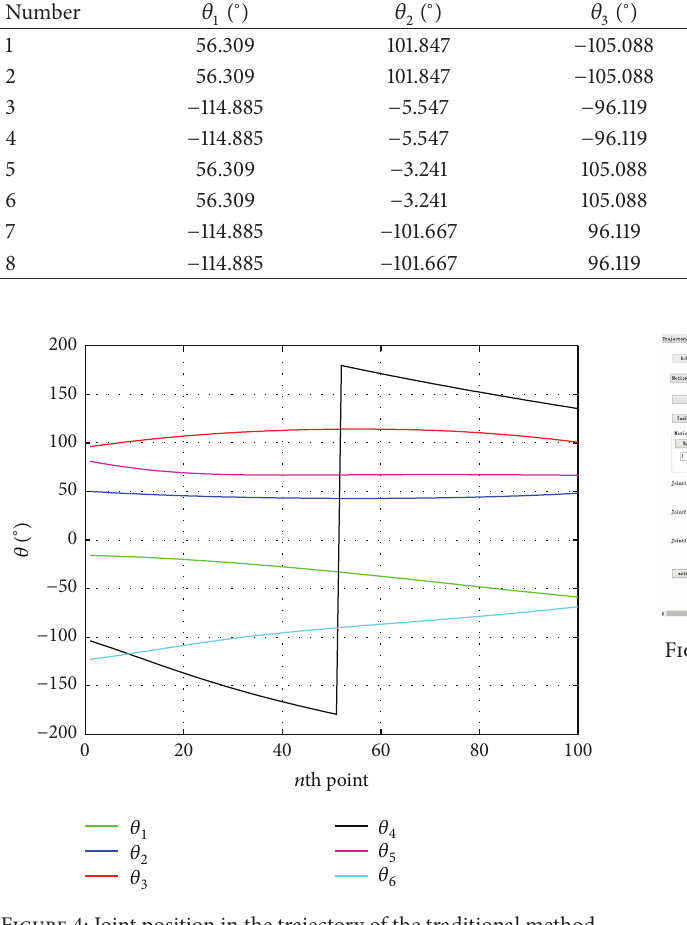
Figure 4: Joint position in the trajectory of the traditional method.